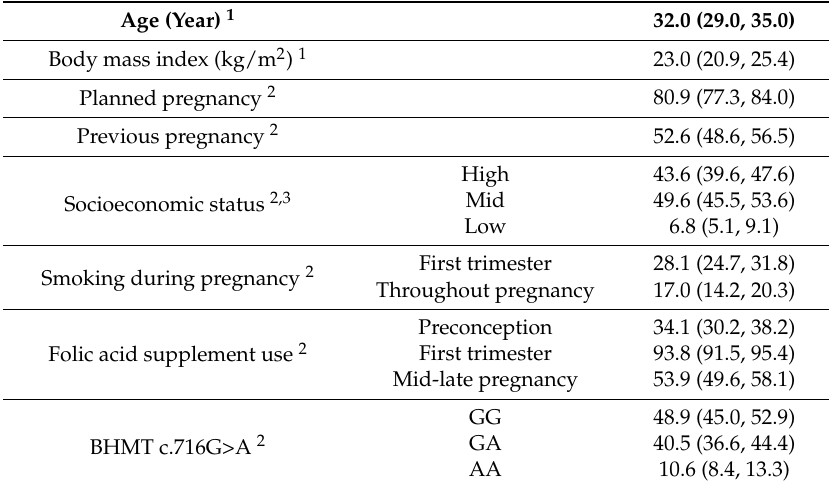
Table 1. Participant characteristics ( n =